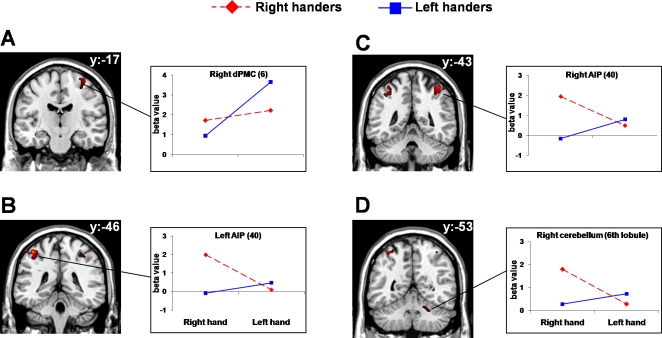
Functional MRI results.Group statistical map resulting from the interaction between handedness and performing hand. The contrast (Right-handers/RH−Right-handers/LH)−(Left-handers/RH−Left-handers/LH) revealed significant effects on brain activity within the dPMC (A), the left (B) and the right (C) AIP, and the right cerebellum (D), corresponding to the 6th lobule. Only activations detected with the Small Volume Correction applied to the random effects analysis are considered (FWE corrected, p<0.05 within the mask). Side panels report the beta values observed for the indicated area. Anatomical specifications are defined on the basis of cytoarchitectonic probabilistic maps (Eickoff et al, 2007). Activation maps are superimposed on the ch2 template provided with the software package MriCRO. Images are displayed in neurological convention. MNI coordinates for the significant areas are reported in Table 1.